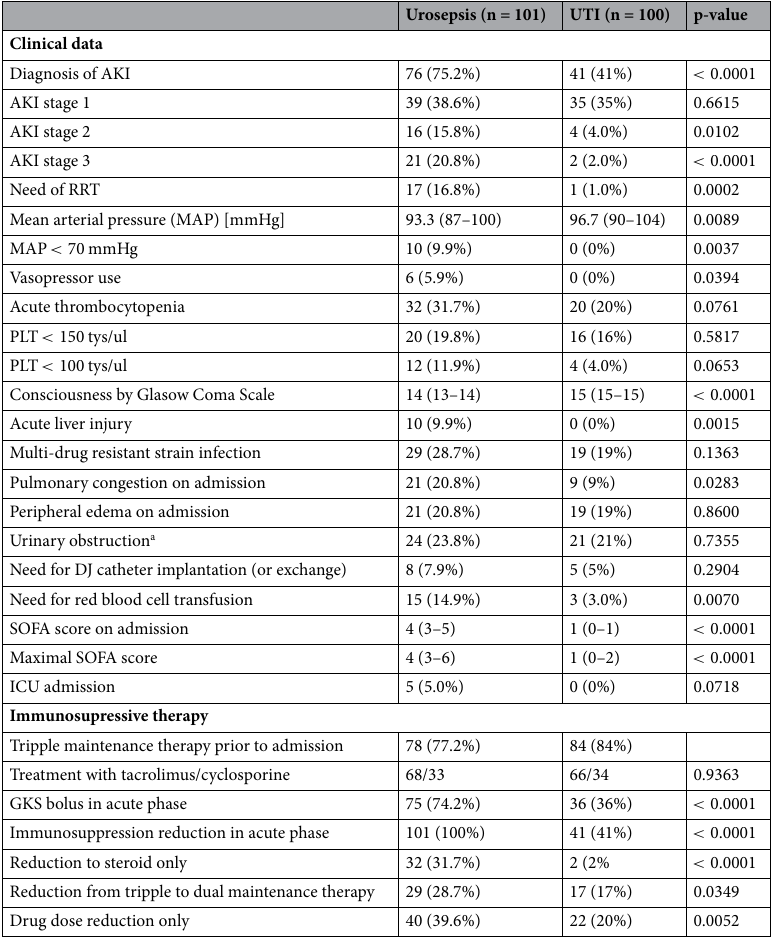
Table 2. Organ function, key clinical parameters and immunosuppressive therapy in patients with urinary sepsis and urinary tract infection. a Defined as one of the following: graft hydronephrosis, residual urine volume after urination < 50 ml or urinary retention confirmed on